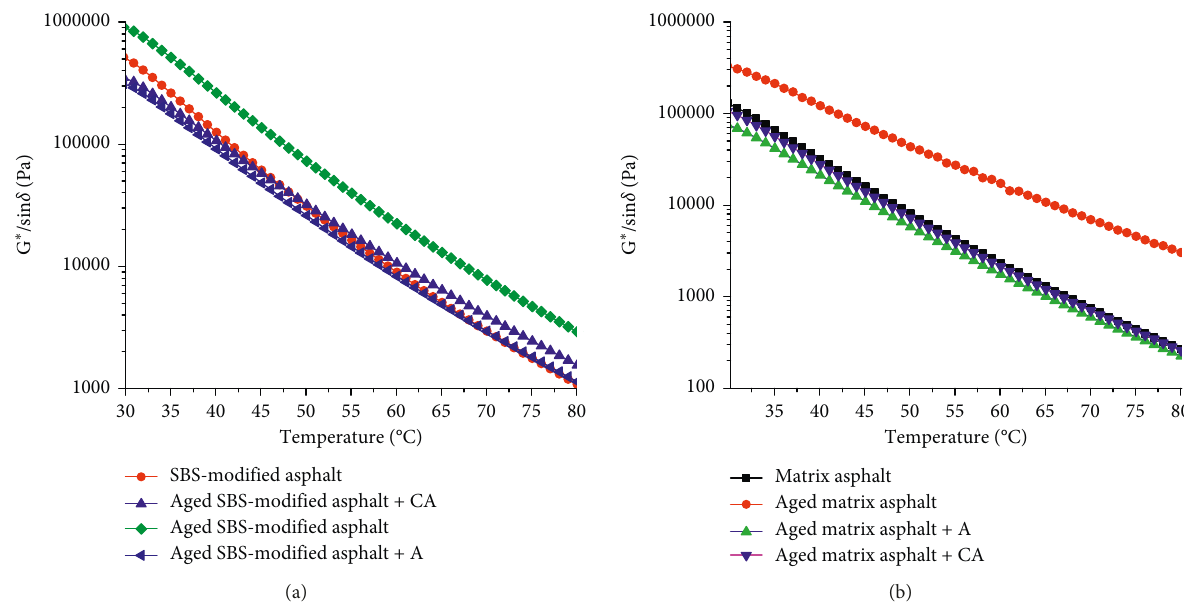
Figure 8: Variation in G ∗ /sin δ before and after asphalt recycling: (a) SBS-modified asphalt; (b) matrix asphalt.